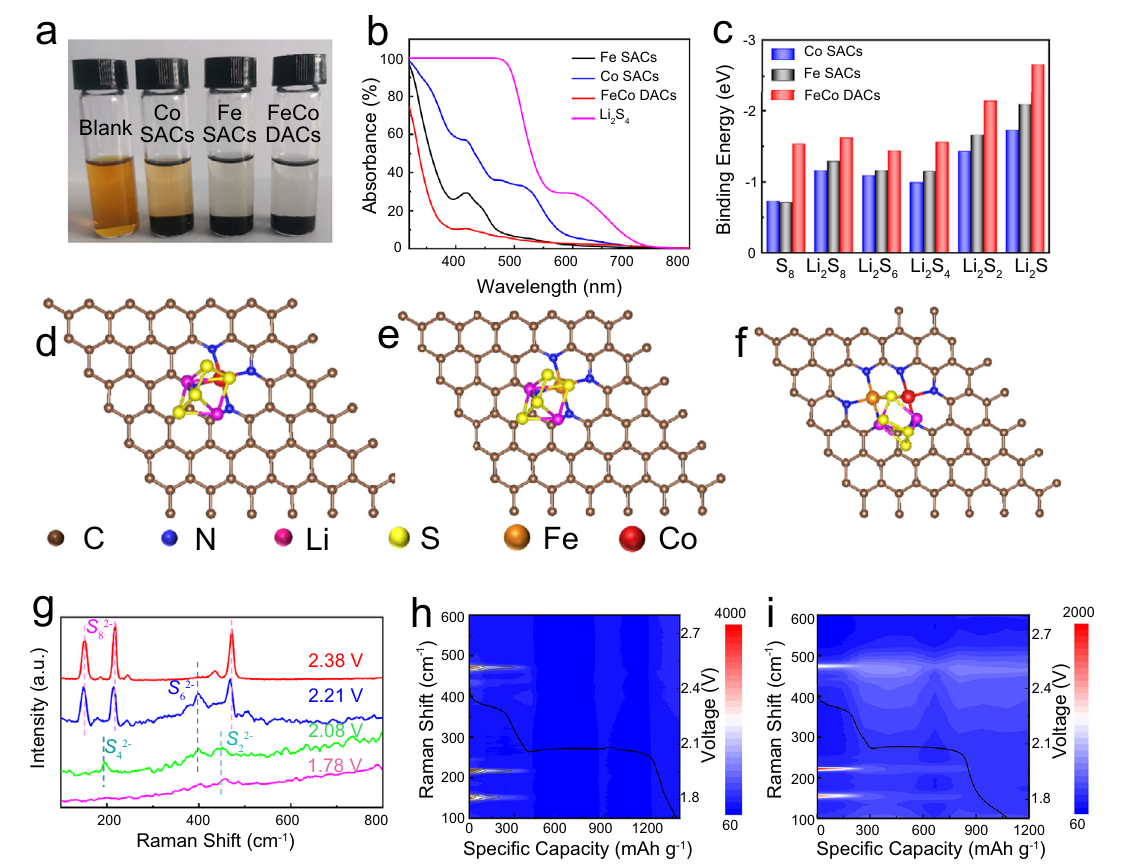
Fig. 5 | Adsorption performance test and in situ characterization. a Optical photograph of visualized adsorption tests of Li 2 S 4 with different materials. b CorrespondingUV – visspectrumsafter12h. c BindingenergiesbetweentheLiPSs and different materials. d – f Adsorption model of Li 2 S 4 on different materials. g In-